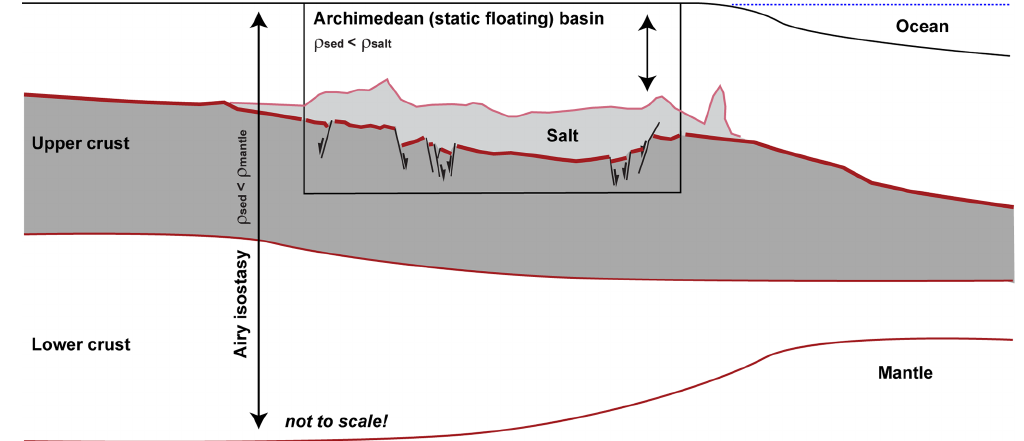
Figure 11. Scale and scope of the salt restoration of this study in comparison to “classic” crustal-scale backstripping (e.g. Turcotte and Schubert, 2014). The concept of isostatic correction is essentially the same for calculating the total mass above a reference datum (i) at great depth below the base of the crust or (ii) at top salt, ignoring everything that happens below that level. Note that volumetrics, lateral distribution, thickness, state of aggregation and physical properties of the respective reconstruction base (salt/evaporites versus the Earth’s mantle) are however fundamentally